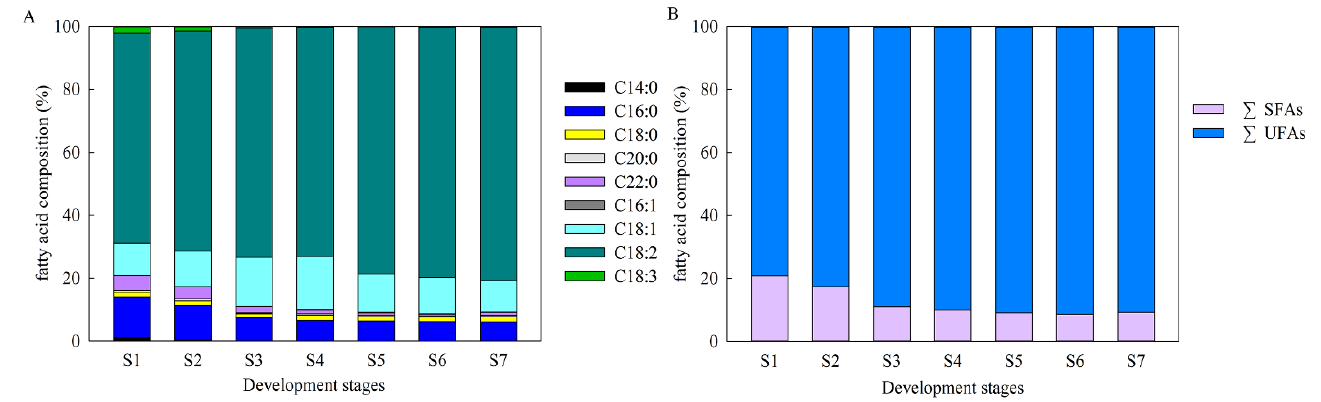
Figure 2. FA composition and content at different A. sphaerocephala seeds developmental stages (%, w / w ). ( A ) Changs in the FA composition during S1~S7; and ( B ) Changs in the SFAs and UFAs during S1~S7.